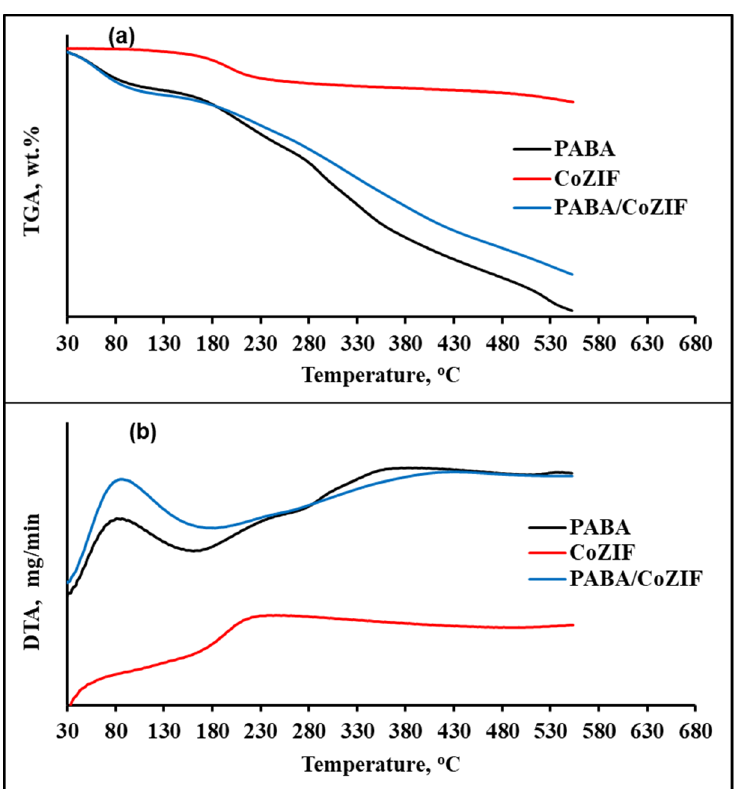
Figure 2. ( a ) Thermogravimetric analysis (TGA) and ( b ) differential thermal analysis (DTA) curves for PABA, CoZIF and the PABA/CoZIF composite.